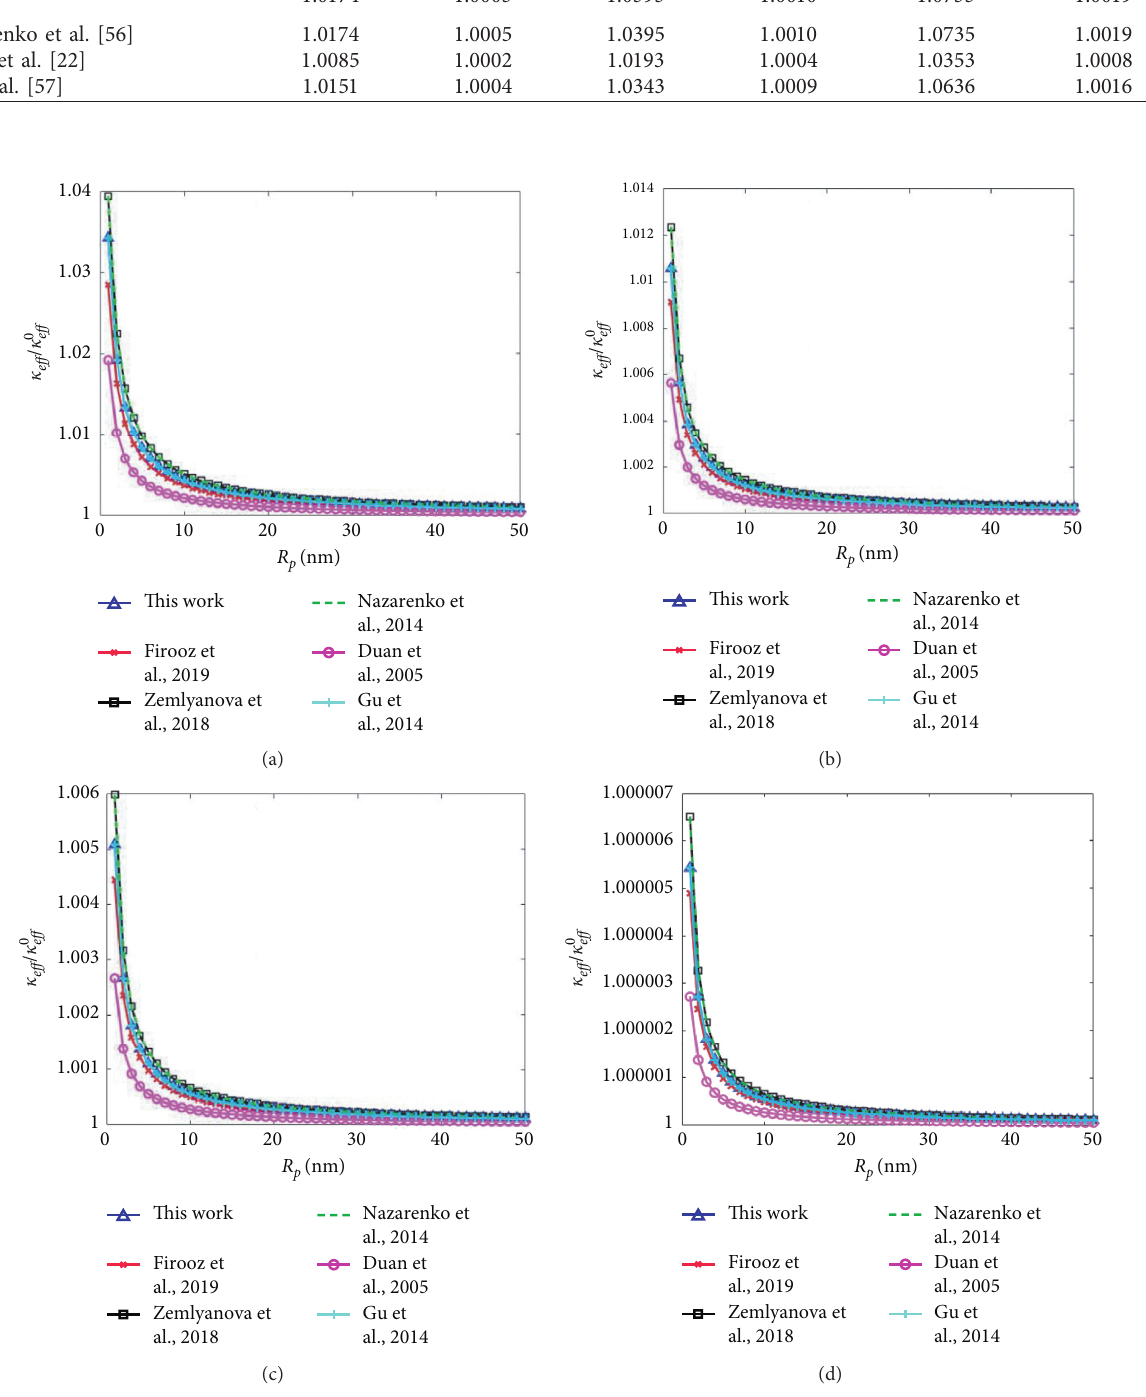
Figure 6: Comparison of effective bulk modulus ratio curves between 6 models, in function of nanoparticle radius, with f E m � 10, (b) E p /E m � 20, (c) E p /E m � 30, and (d) E p /E m � 10 3